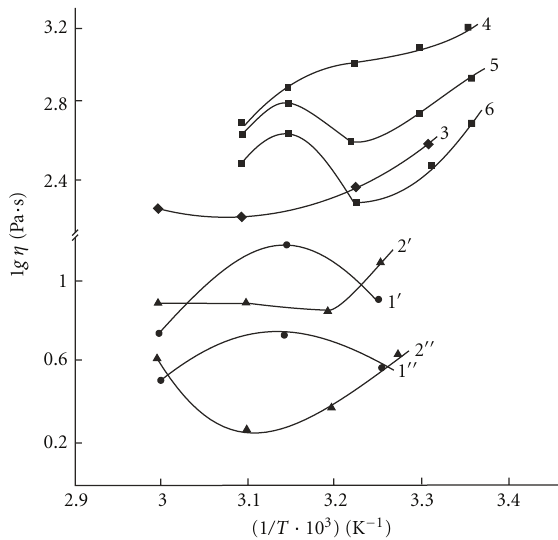
Figure 8: Dependence of viscosity on the inverse temperature for a nitromethane solution of CTA with polymer concentrations of 6 (1 (cid:6) , 1 (cid:6)(cid:6) ), 8 (2 (cid:6) , 2 (cid:6)(cid:6) ), 9wt% (3), and 13 wt% (4, 5, 6) at the following shear stresses (lg σ , (Pa)): 1.8 (1 (cid:6) , 2 (cid:6) , 4), 2.1 (3), 2.2 (1 (cid:6)(cid:6) , 2 (cid:6)(cid:6) , 5), and 2.5